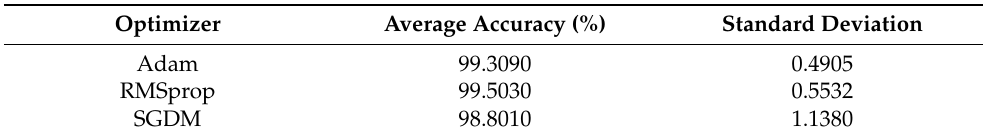
Table 6. The classification results according to changes in the optimizer of the 1D CNN–GRU with the C4G3 * structure and 140-90-30 hidden